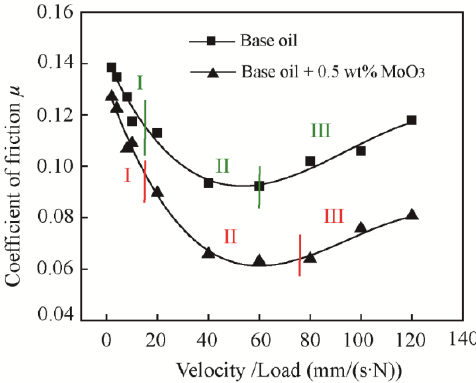
Figure 11. Stribeck curves of base oil and with the addition of 0.5 wt % MoO 3 . Region I: boundary lubrication; region II: mixed lubrication; and region III: hydrodynamic lubrication.